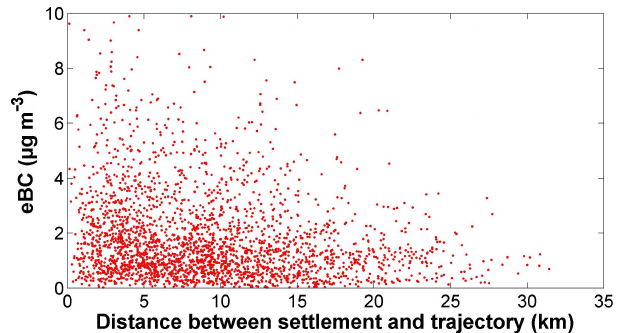
Figure 12. eBC concentration plotted against the shortest distances that hourly arriving back trajectories had passed informal or semi- formal settlements during the winter months of June and July at Elandsfontein.